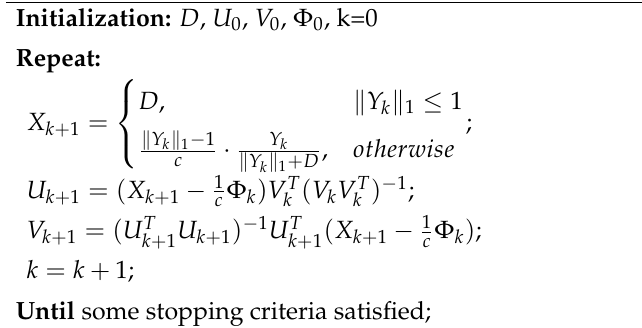
Algorithm 2 The max-rank-decomposition-based